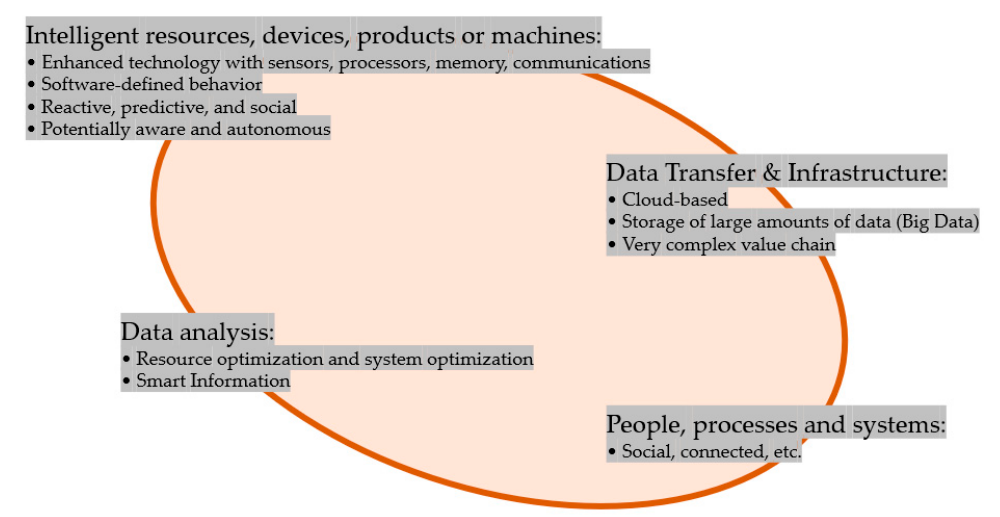
Figure 2. Agriculture 4.0 and the Virtual Object Structure.